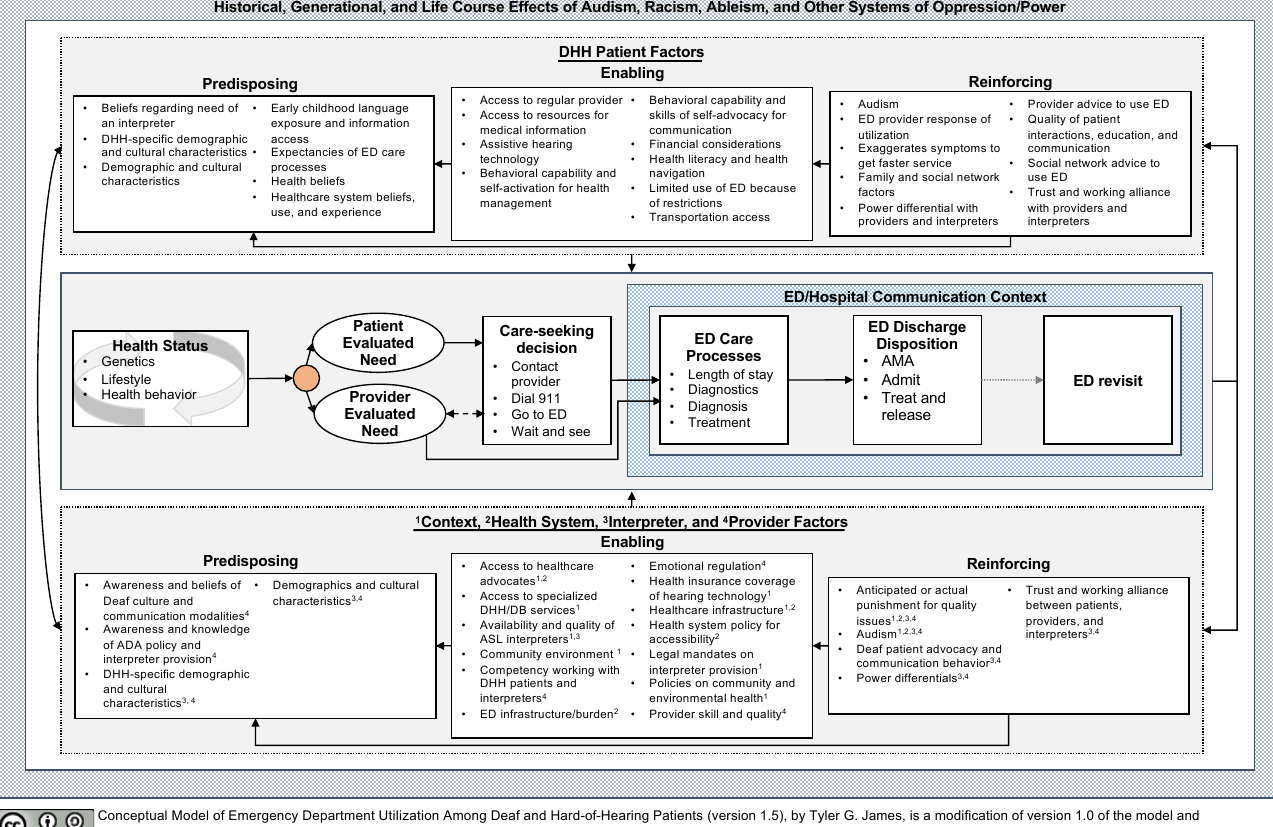
Figure 1. Conceptual model of emergency department utilization among deaf and hard-of-hearing